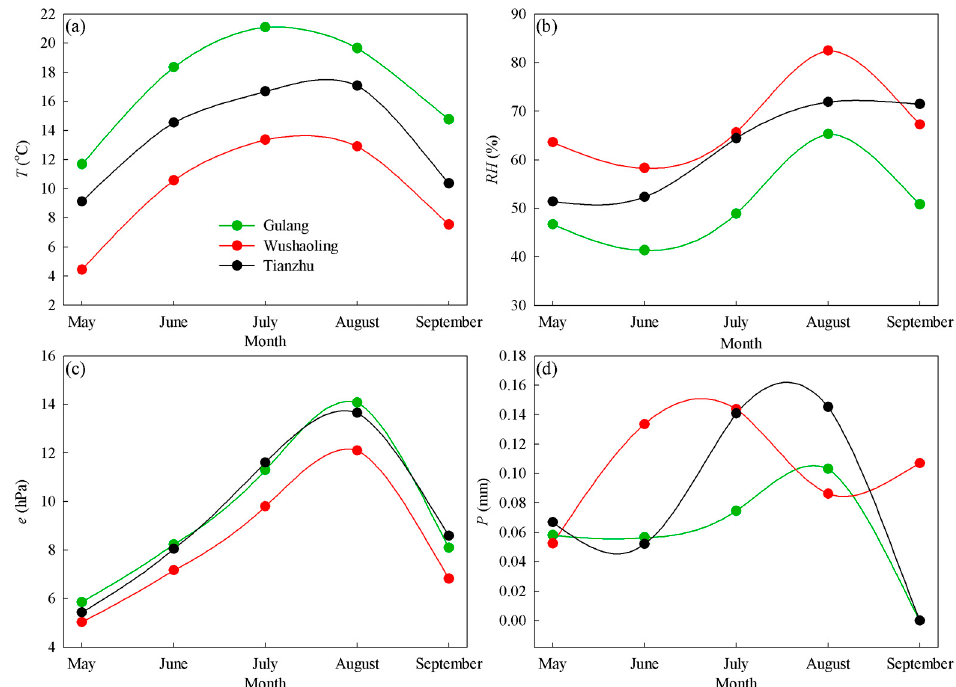
Figure 9. The monthly variations in major meteorological parameters: ( a ) is air temperature, ( b ) is relative humidity, ( c ) is vapor pressure, and ( d ) is precipitation amount.